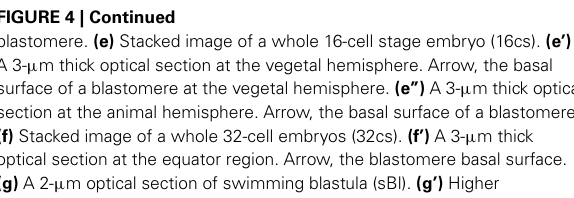
FIGURE 4 | Continued blastomere. (e) Stacked image of a whole 16-cell stage embryo (16cs). (e’) A 3- µ m thick optical section at the vegetal hemisphere. Arrow, the basal surface of a blastomere at the vegetal hemisphere. (e”) A 3- µ m thick optical section at the animal hemisphere. Arrow, the basal surface of a blastomere. (f) Stacked image of a whole 32-cell embryos (32cs). (f’) A 3- µ m thick optical section at the equator region. Arrow, the blastomere basal surface. (g) A 2- µ m optical section of swimming blastula (sBl). (g’) Higher